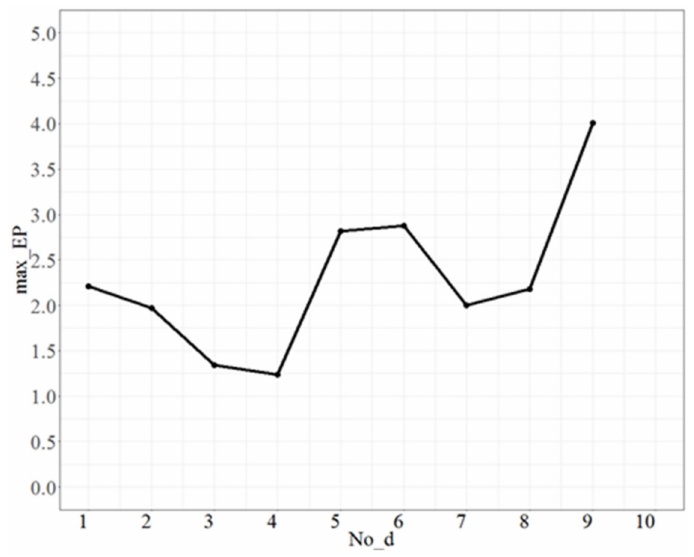
Figure 1. The max_EP plot as No_d